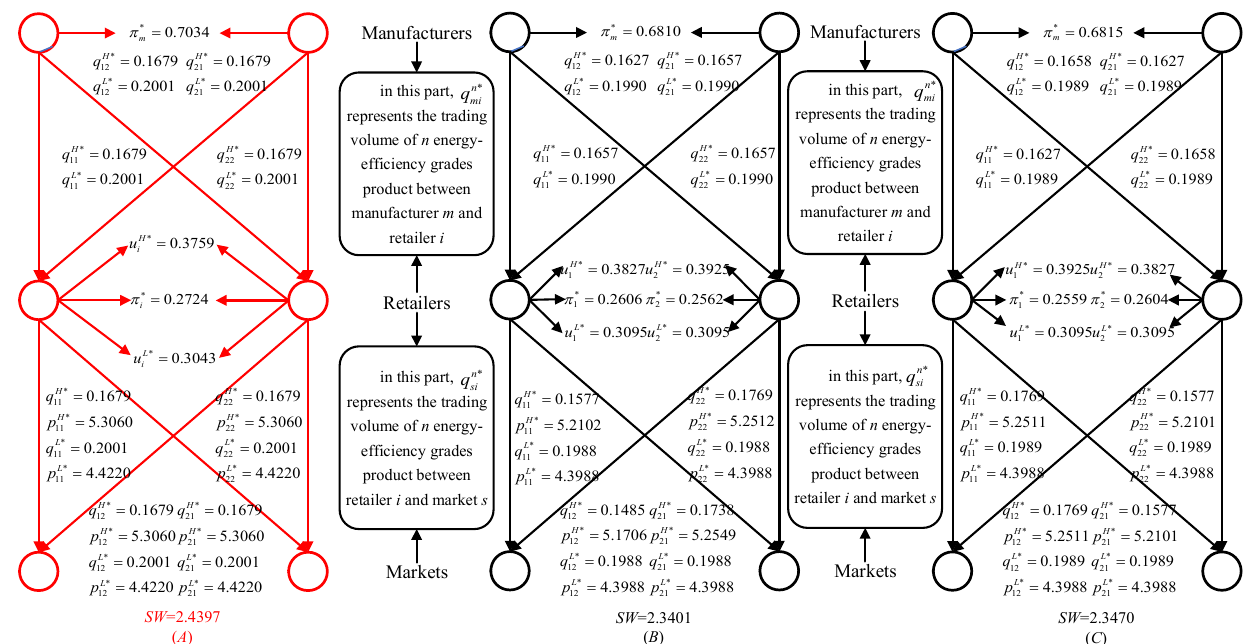
Figure 5. When the subsidy rate is 0, the SCNE results in different scenarios. ( A ) there is no difference in the demand scale of the same retailer in the same market. ( B ) different retailers in the same market have different demand scales. ( C ) different markets have different demand scales for the same retailer.